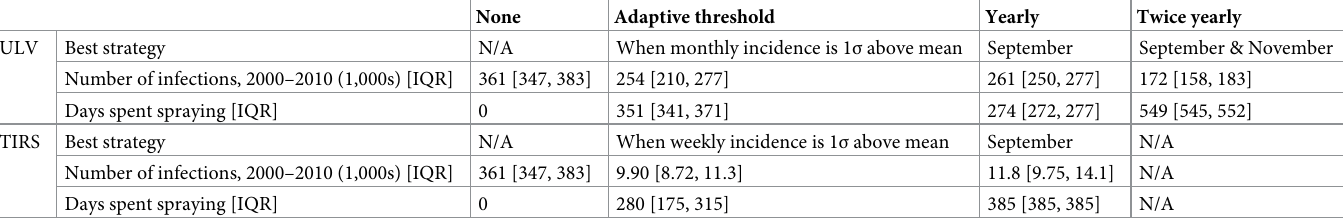
Table 2. Summary of results and predicted number of infections. N/A denotes not applicable, numbers in cells represent the number of infections over the 11 year period in 1,000s, and the numbers in brackets represent the inter-quartile range (IQR). None Adaptive threshold Yearly Twice yearly ULV Best strategy N/A When monthly incidence is 1 σ above mean